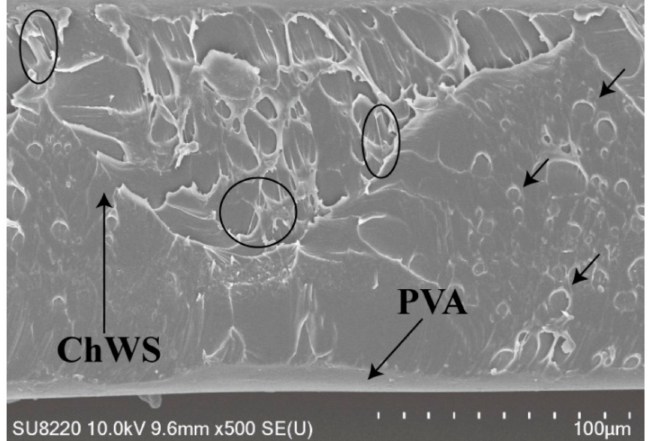
Figure 8. Fractography of heat treated PVA/ChWs composite film after cutting by ion